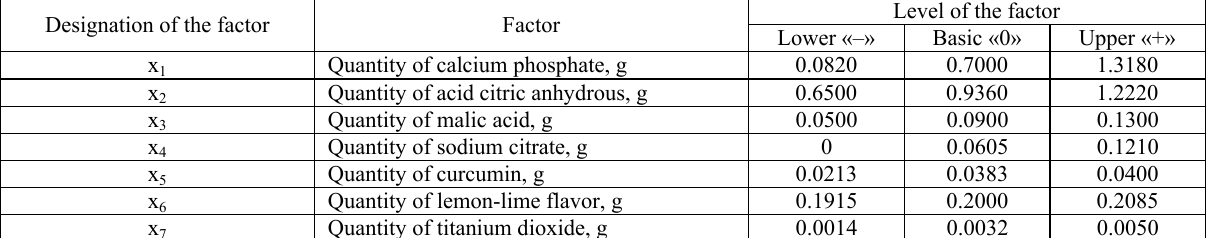
Factors and their levels in the study of quantitative characteristics of excipients in powder in sachet packs Designation of the